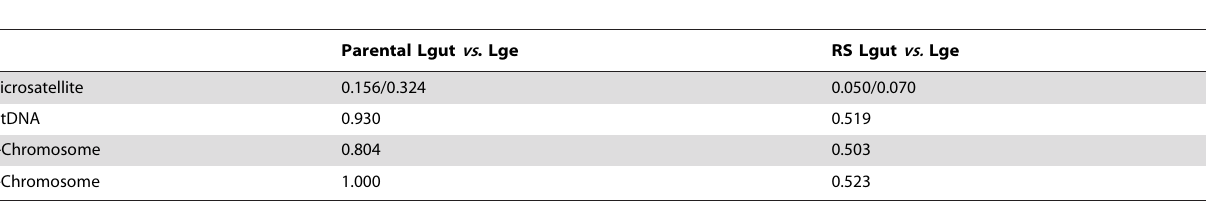
Table 1. Levels of genetic differentiation between parental populations of both species and between samples collected from Rio Grande do Sul state